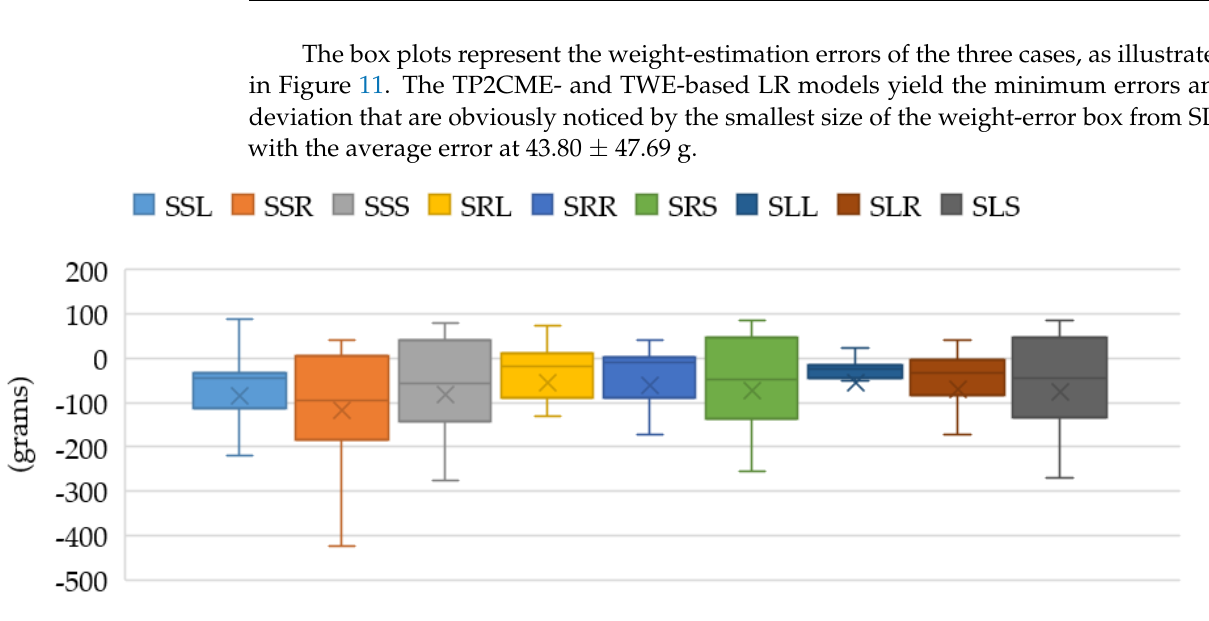
Figure 11. Box-plot comparison of Tilapia-weight estimating errors of the nine candidates corre- sponding to Case 1, Case 2, and Case 3 for determining the regression method to TP2CME and TWE.